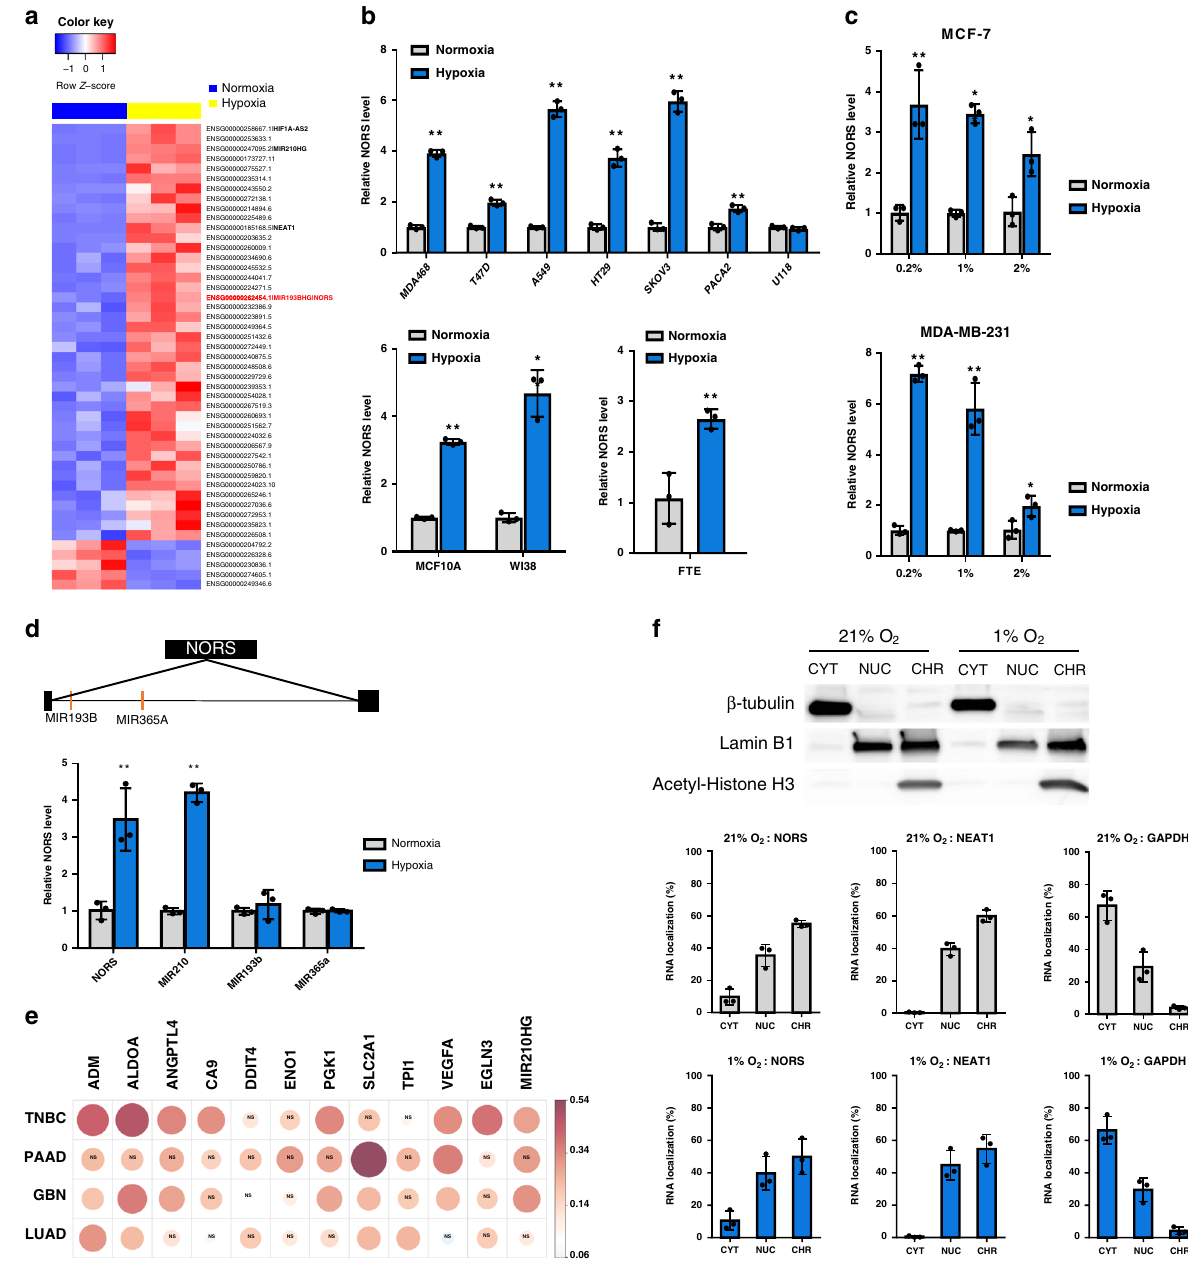
Fig. 1 lincNORS is an oxygen-regulated, nucleus-located lncRNA. a Heatmap depicting the expression of 47 lincRNAs signi fi cantly upregulated (fold change ≥ 2 or ≤ 0.5) in MCF-7 cells under hypoxia (1% O 2 , 24 h) versus normoxia (21% O 2 , 24 h). Color intensity represents RPKM scaled by the row.